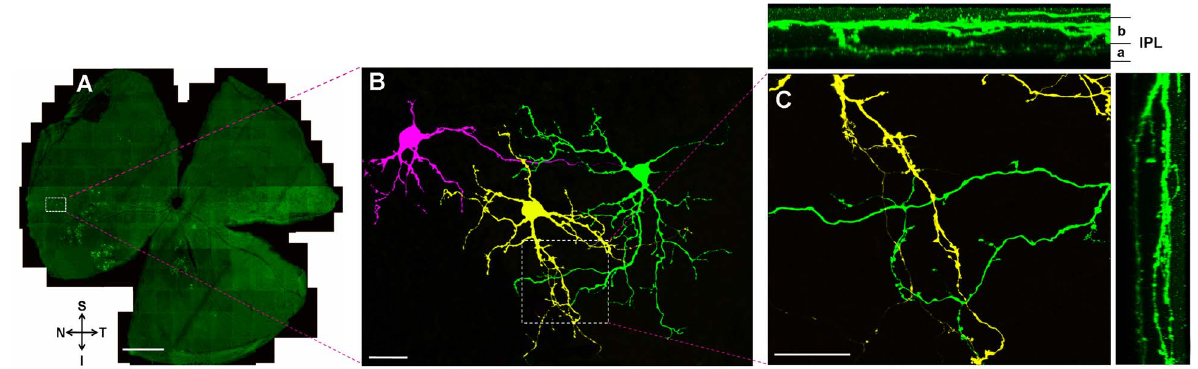
Figure 7. Dendritic fields that sometimes overlap with one another among caudal periaqueductal gray (cPAG)-projecting retinal ganglion cells (RGCs). (A) Intracellularly injected cPAG-projecting RGCs in a whole-mounted retina. S: superior; I: inferior; N: nasal; T: temporal. (B) The white box in (A) viewed under high magnification. In this field three neighboring cPAG-projecting RGCs that have overlapped dendritic fields were labeled with three different colors (magenta, yellow and green). (C) Three dimensional reconstruction of overlapped dendritic fields. IPL: inner plexiform layer; a: sublamina a of inner plexiform layer; b: sublamina b of inner plexiform layer. Scale bars: 1 mm in A; 20 m m in B; 10 m m in C.